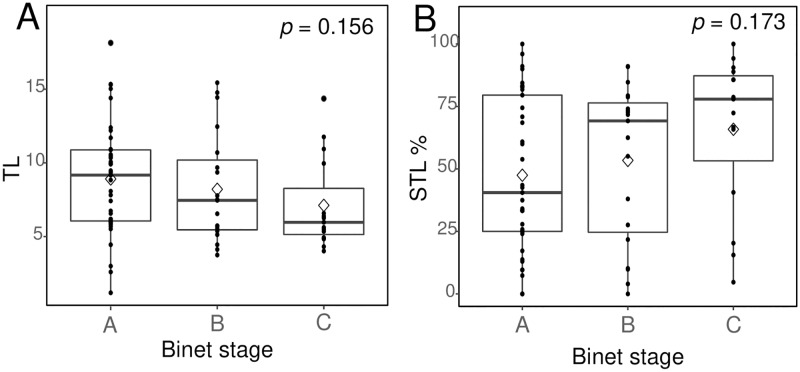
Comparison of TL and the STL% among the Binet stages.A worse Binet stage corresponds to a shorter TL (stage A = 8.91, B = 8.21, C = 7.12, mean values) and a greater STL% (stage A = 47.5, B = 51.4, C = 65.9, mean value). However, no statistically significant differences were found among Binet stages (p = 0.156 for TLs, p = 0.173 for the STL%).